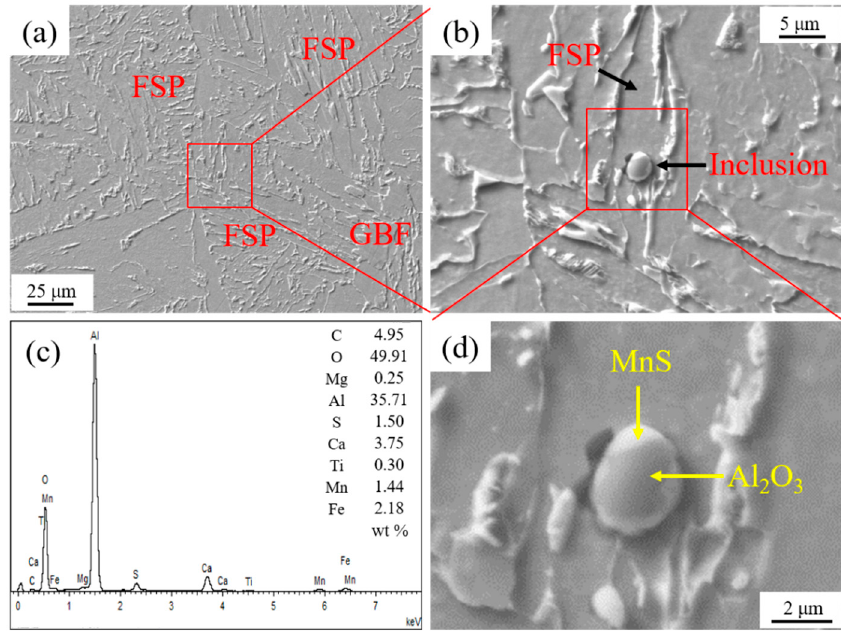
Figure 4. Inclusion related to HAZ microstructure in experimental steel A. ( a ) HAZ microstructure, ( b ) inclusion, ( c ) energy dispersive spectrometer (EDS) analysis result of inclusion, and ( d ) component of inclusion.